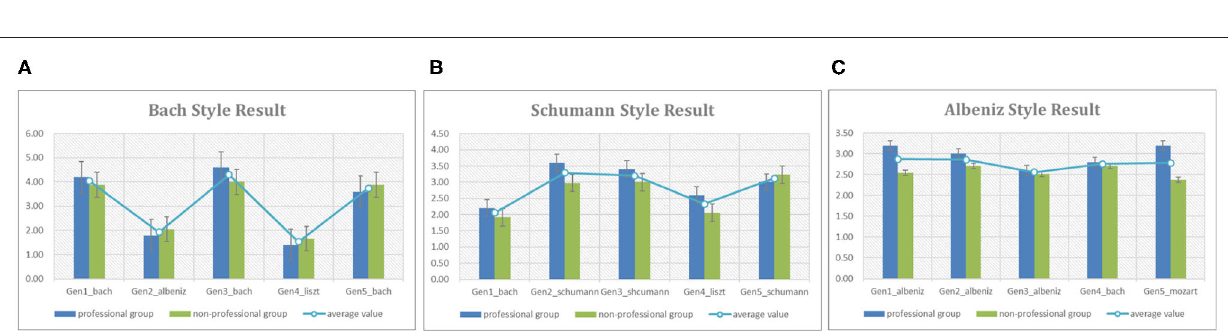
FIGURE 14 | The statistical results of genre-based composition, (A) shows the results given by professional (blue bars) and non-professional (orange bars) groups on whether the melody have the characteristics of Baroque period, (B,C) exhibit the results of classical and romantic periods.